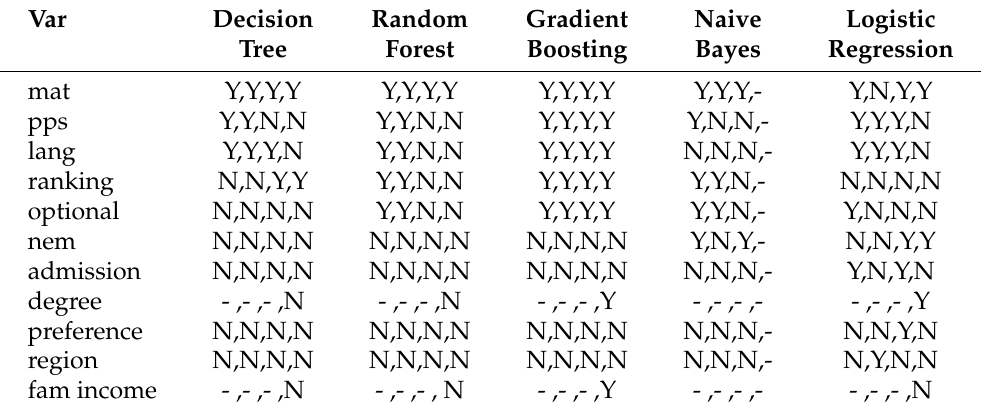
Table 7. Feature importance, for each model and dataset. The pattern of each cell represents the datasets “combined,UAI,U Talca,U Talca